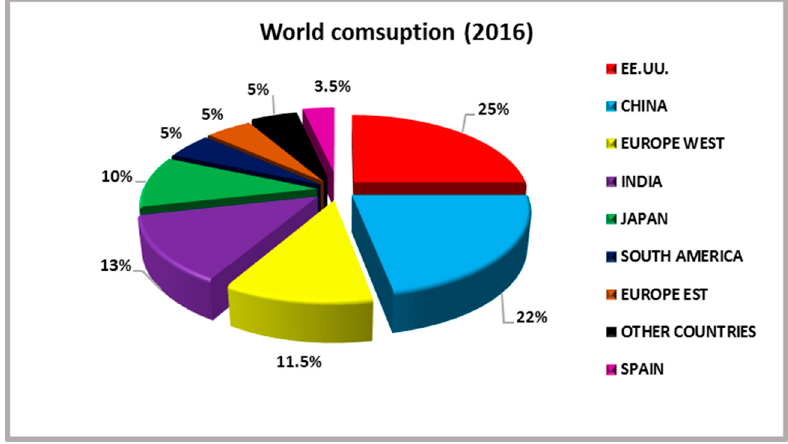
Figure 2. World comsuption of activated carbon year